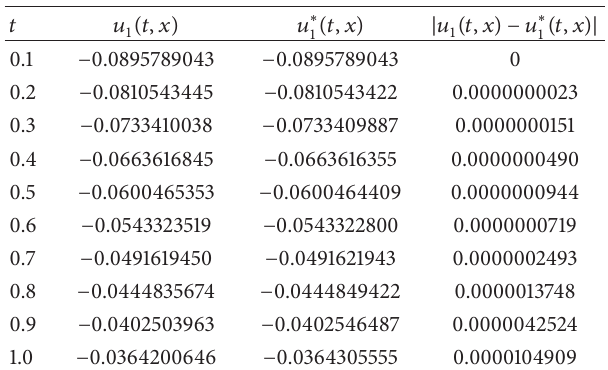
Table 1: The numerical and exact solution of the test problem(32), where 𝑢 1 (𝑡,𝑥) is the exact solution and 𝑢 ∗ 1 (𝑡,𝑥) is the numerical solution, for 𝑥 = 0.1 .